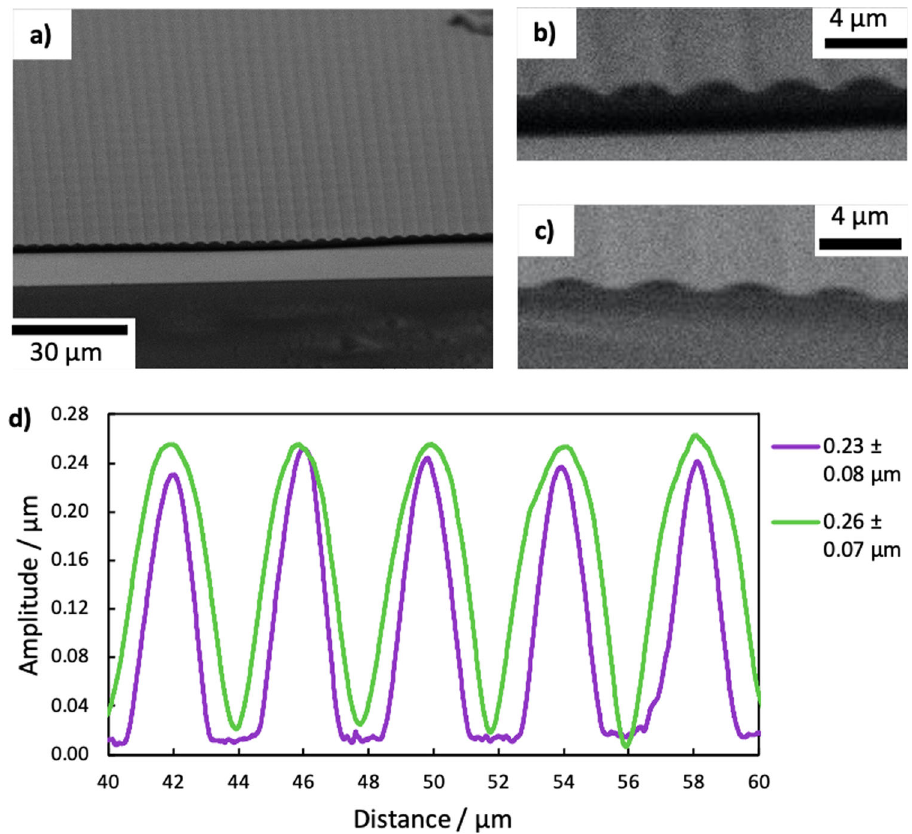
Fig. 9 Fabrication of gratings for the VGA-FLC device. SEM images of SU-8 surface relief gratings. a , b a 2 : 32 ± 0 : 05 μ m fi lm thickness, with a dose of 500mJcm 2 , resulting in a peak-to-peak amplitude of 0 : 77 ± 0 : 02 μ m with 1.6 μ m offset. c A 0.66 ± 0.09 μ m fi lm thickness, with a dose of 1000mJcm 2 , resulting in a peak-to-peak amplitude of 0 : 59 ± 0 : 05 μ m with no offset. d The surface pro fi les of the two master gratings used in the VGA-FLC devices. These masters were created using a 30% dilution of SU-8 2025, and exposed using a 2 µ m, 375 nm laser in the direct-write laser lithography system. Final SU-8 layer thickness: 0 : 84 ± 0 : 05 μ m. Grating peak-to-peak amplitudes: Purple line: 0 : 23 ± 0 : 08 μ m, using a dose of 550mJcm (cid:2) 2 , and green line: 0.26 ± 0.07 μ m, using a dose of 1200mJcm (cid:2) 2